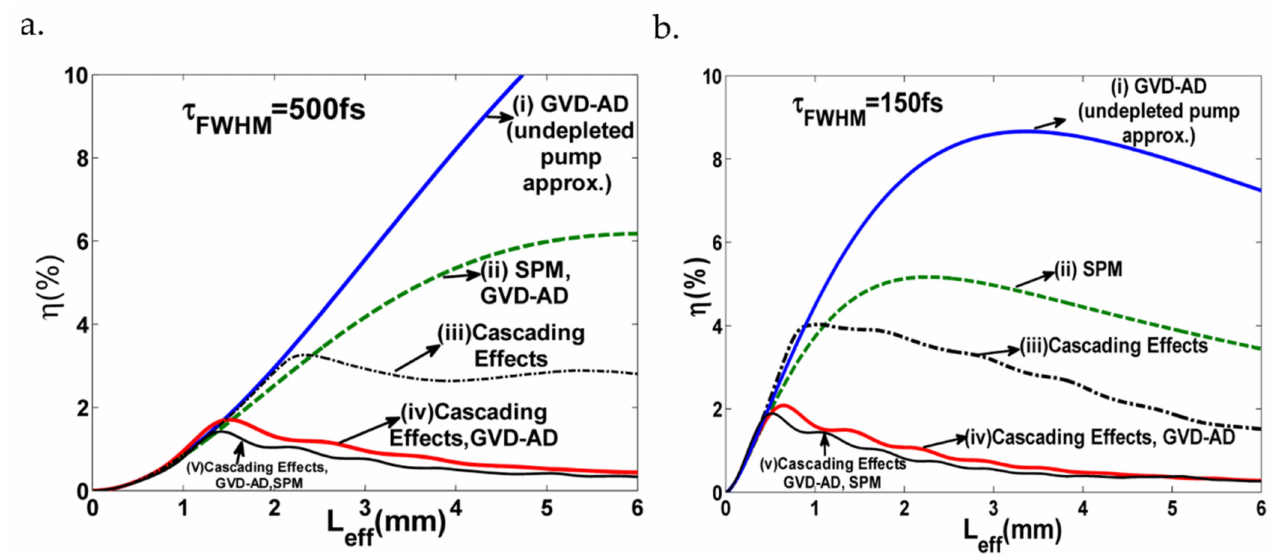
Figure 4. The relation between energy conversion efficiency and effective length when the model includes different effects. Most of the reduction in efficiency comes from the GVD-AD, together with the cascading effects for both ( a ) a long pulse duration of 500 fs with 40 GW/cm 2 and ( b ) a shorter pulse of 150 fs with triple peak intensity. [Reprinted/Adapted] with permission from [73] © The Optical